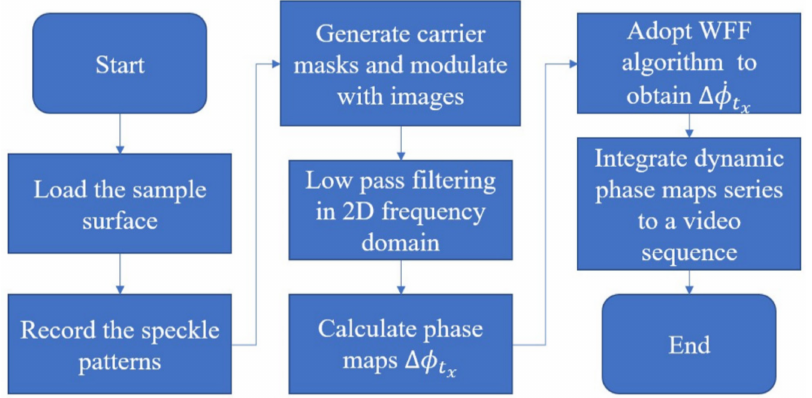
Figure 3. Flow chart of the proposed method.